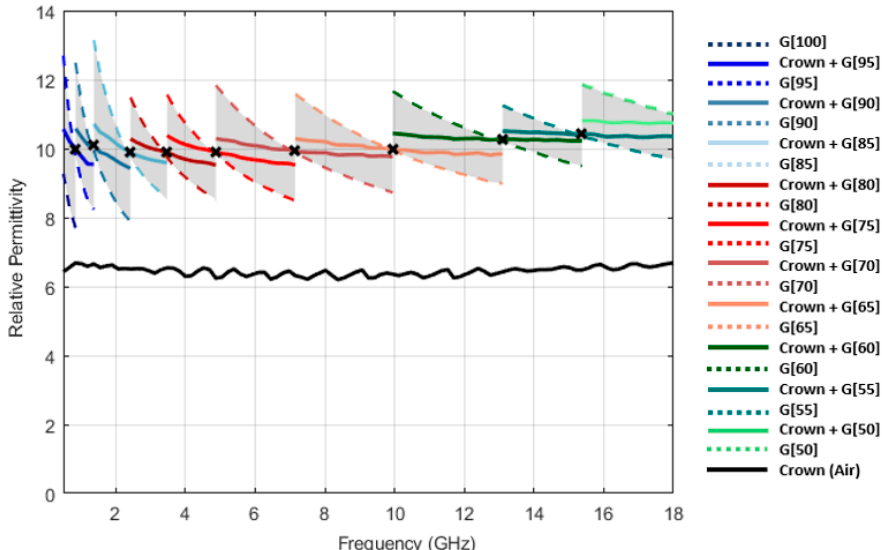
Figure 6. Example of the estimated relative permittivity for a premolar crown with the application of multiple coupling media. For each frequency range delimited by intersection points (black crosses), the relative permittivity of two coupling media (dashed line) and the relative permittivity resulting from the application of these media on the crown (solid line) are shown. The highest measured relative permittivity without application of coupling medium is represented by the solid black line as a reference. Glycerin percentage, by volume, in the coupling medium solution is given by X in the G[X] expression.